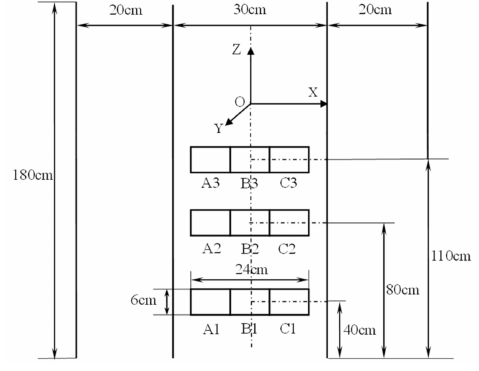
Figure 2. Plan view of the imaged locations.